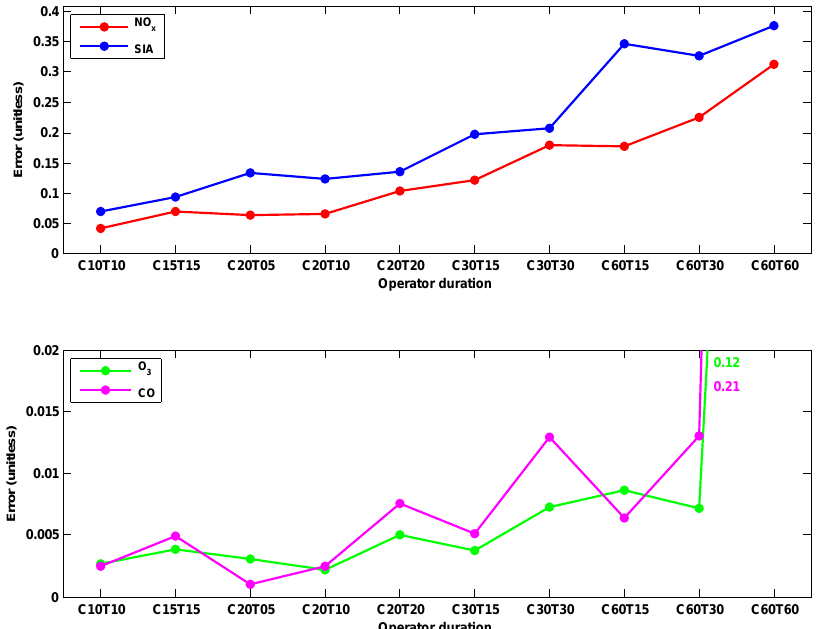
Figure 4. Relative simulation error of different species ( E s , Eq. 3) with various operator durations at 2 ◦ × 2.5 ◦ horizontal resolution. sim Colored lines and dots represent the relative simulation error for nitrogen oxides (NO x ; red), secondary inorganic aerosols (SIA; blue), ozone (O 3 ; green), and carbon monoxide (CO; magenta). Simulations are represented in the abscissa as CccT tt with chemical operator duration, C = cc min, and transport operator duration, T = tt